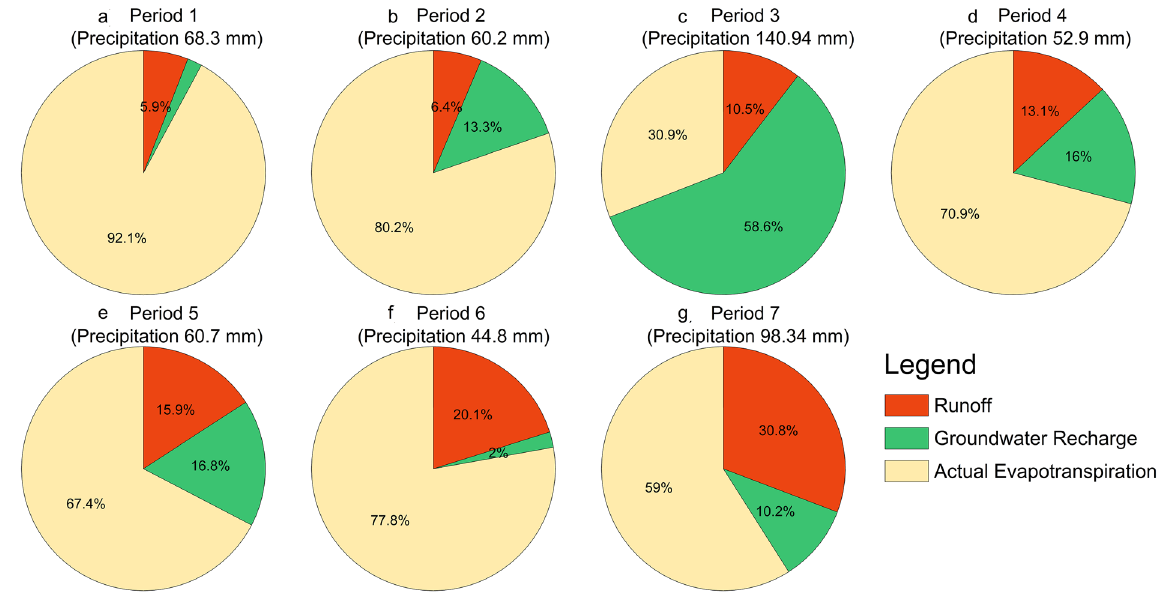
Figure 5. The distribution of Doha rainfall between runoff, groundwater recharge, and actual evapotranspiration during the seven studies periods. Annual rainfall is shown under each period name. The maps were created using Python 3.9 (https:// www. python.